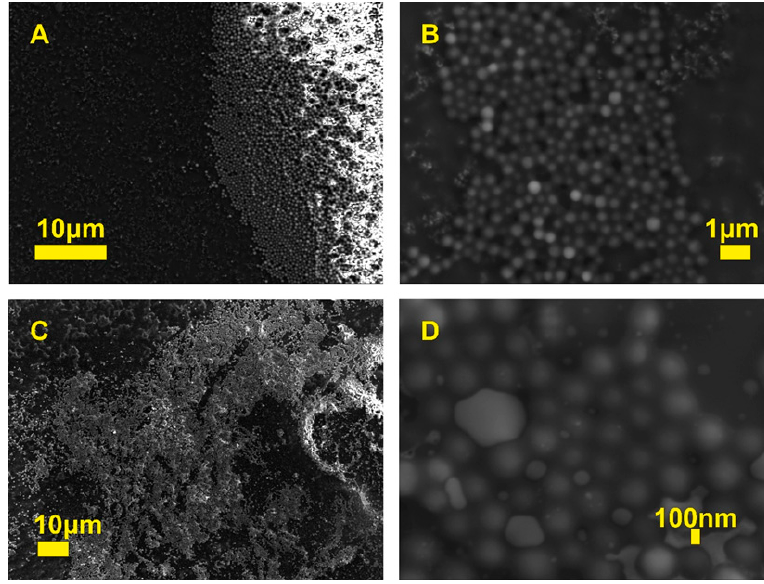
Figure 3. SEM images of HFBMA NPs at different magnifications: H26 ( A and B ), H27 ( C and D ).